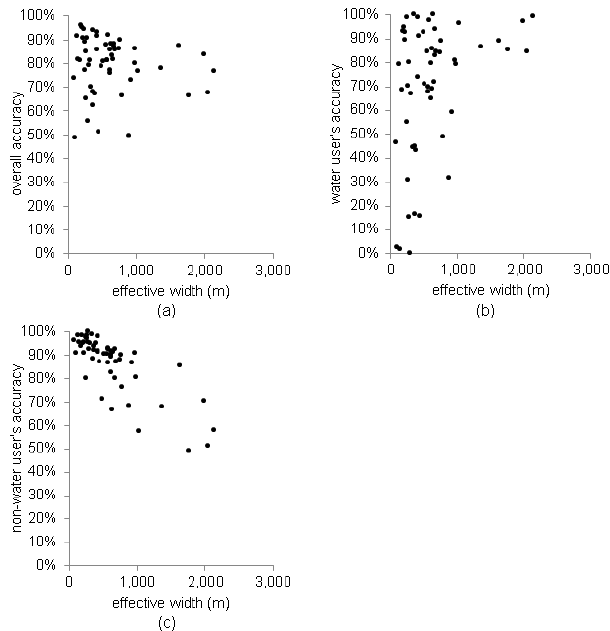
Figure 3. Accuracy assessment as a function of W e from a 33% sample of post filtered images is presented here, with overall ac- curacy (a) , water user’s accuracy (b) , and non-water user’s accu- racy (c) all showing acceptable performance. Overall accuracy and water user’s accuracy are not strongly correlated with W e , suggest- ing that the amount of water in the scene does not strongly influ- ence the calculation of water area. Non-water accuracy, however, is strongly affected by the amount of water in the scene, as the Isortoq River occupies nearly the entire valley at high flow, making classi- fication of a few scattered non-water pixels challenging.